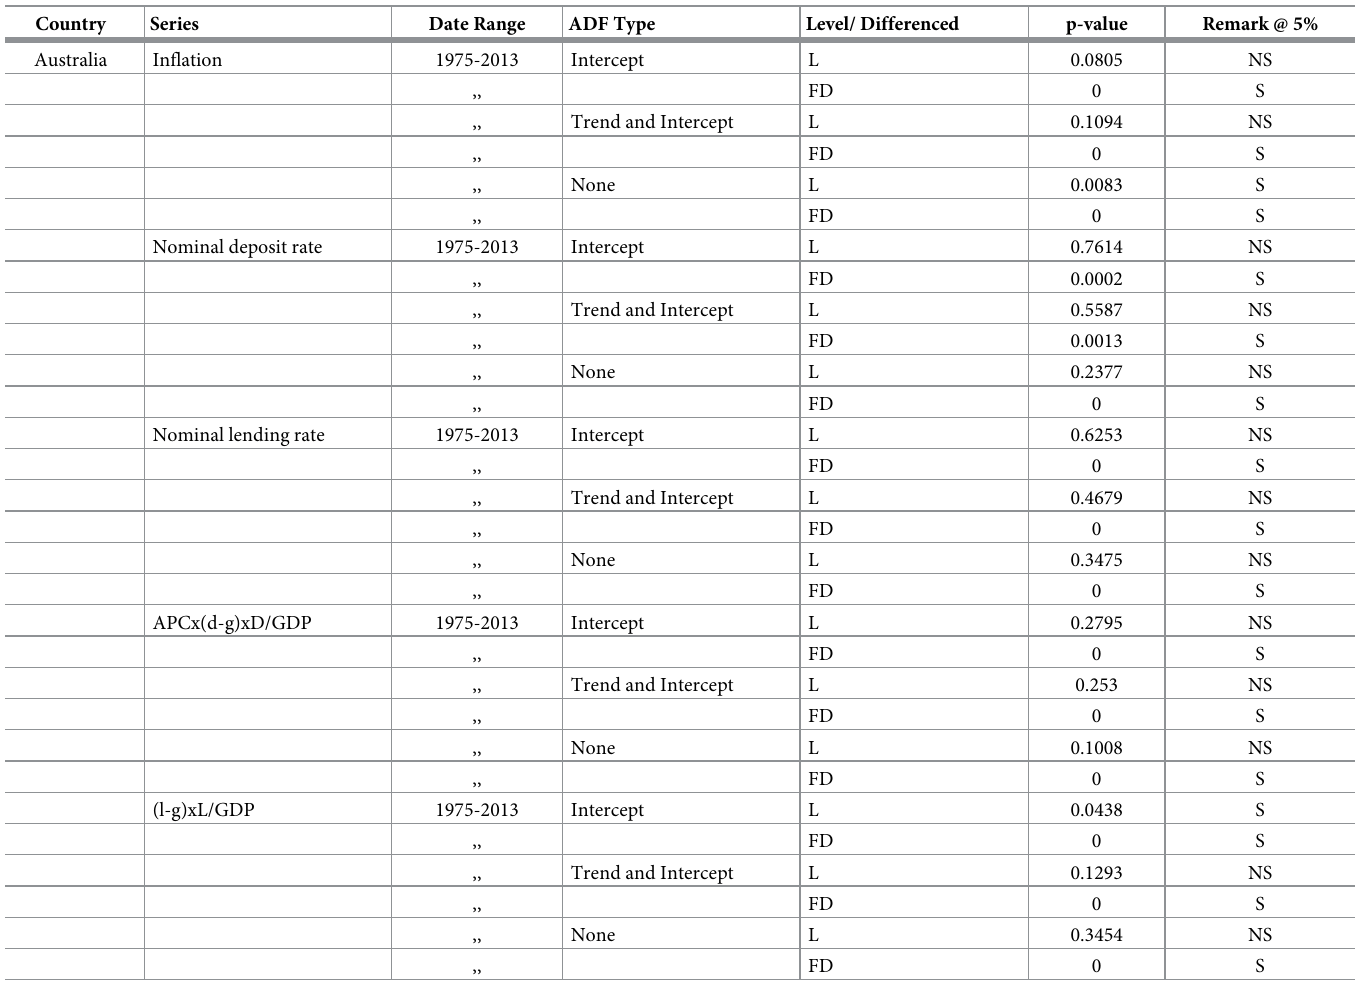
Table 1. ADF Unit Root